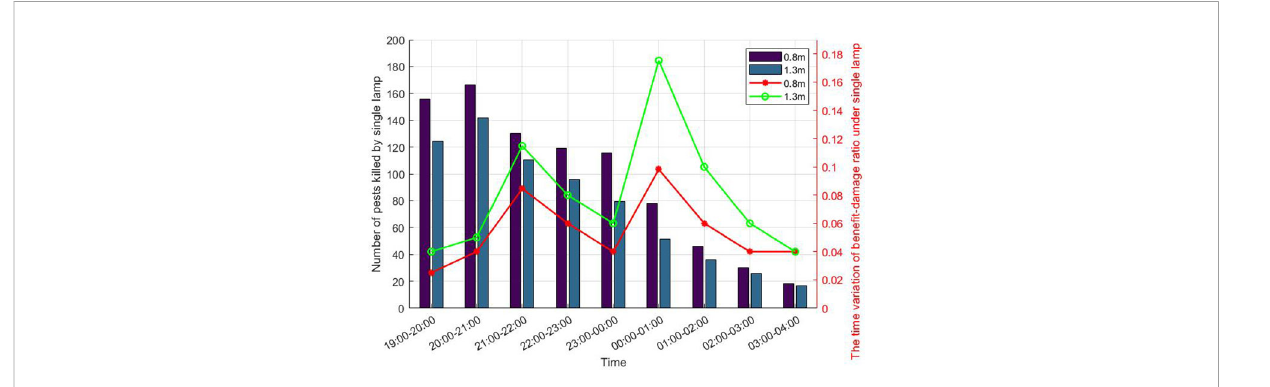
FIGURE 8 The phototactic rhythm of vegetable garden pests. The left label is the phototactic rhythm of vegetable pests, and the right label is the phototactic rhythm of SILs with different